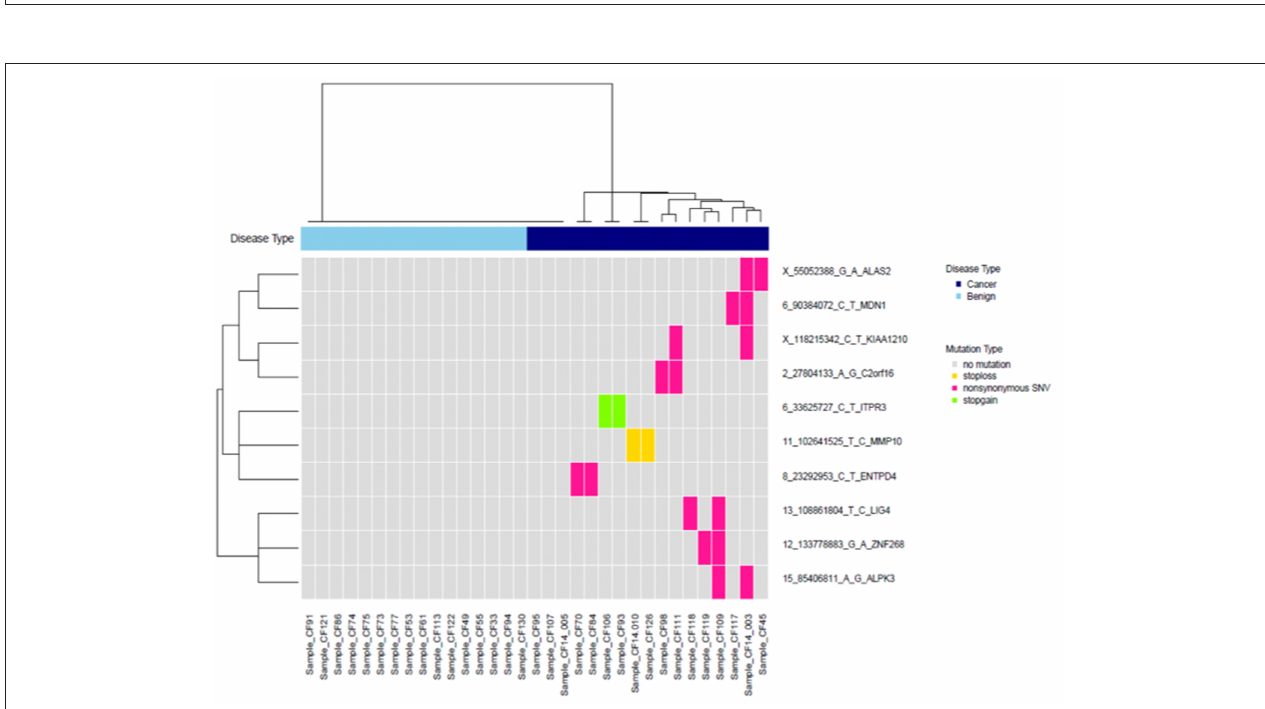
FIGURE 3 | Clustering of 10 high-confidence somatic variants observed in at least two patients with cancer, but not in the control group.